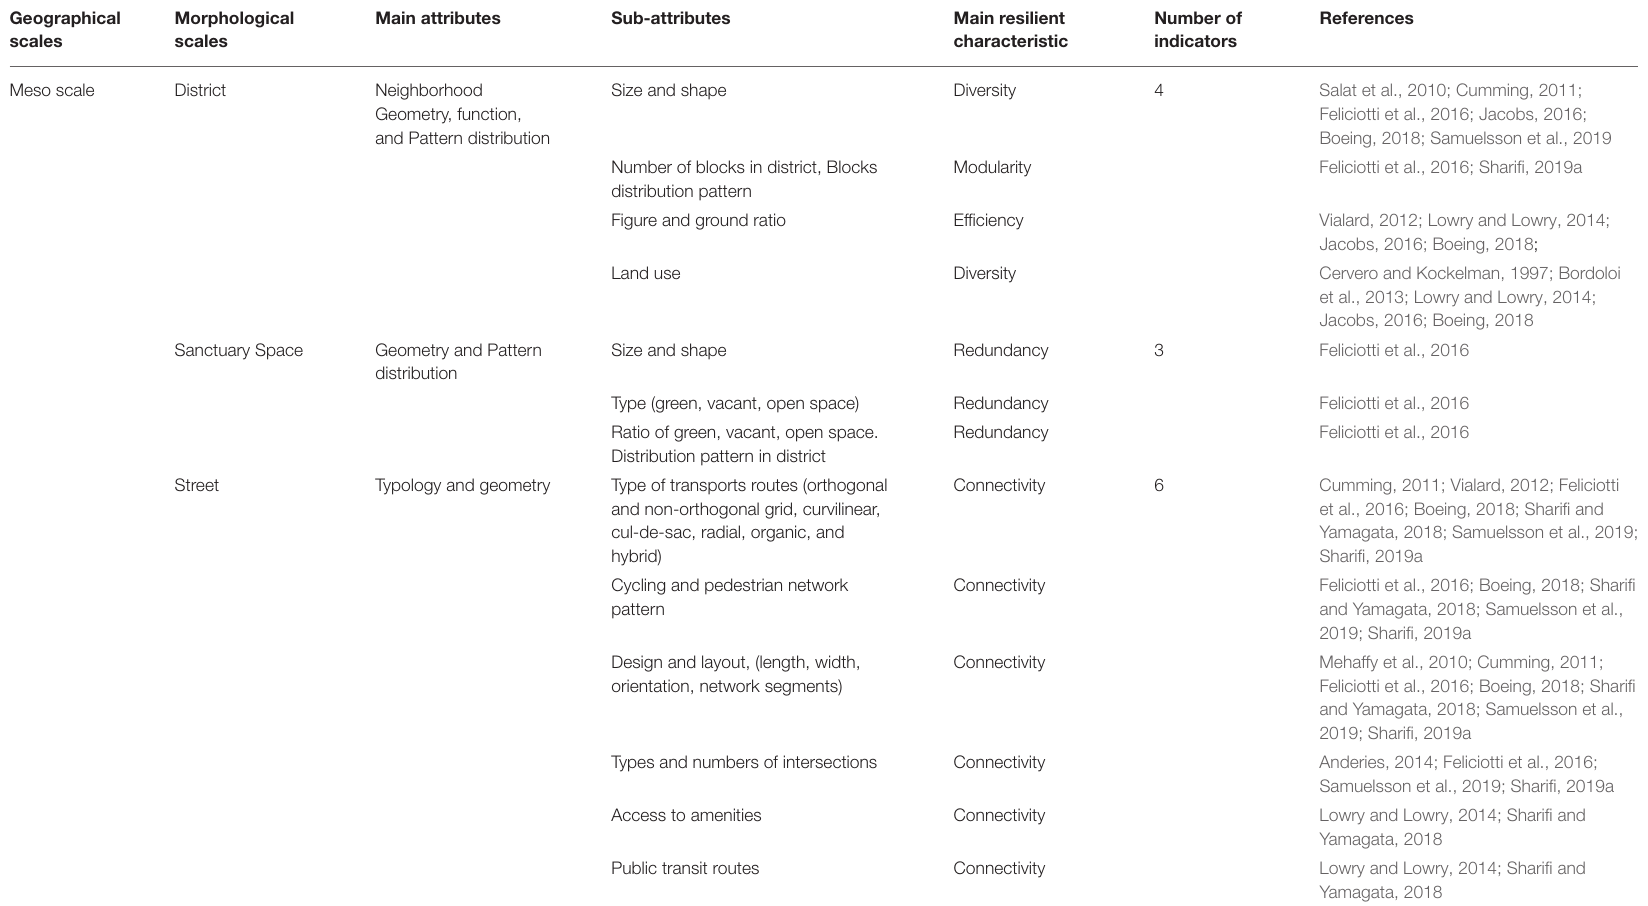
TABLE 4 | A link between main urban-form attributes of a neighborhood and resilient characteristics at different hierarchal scales. Geographical